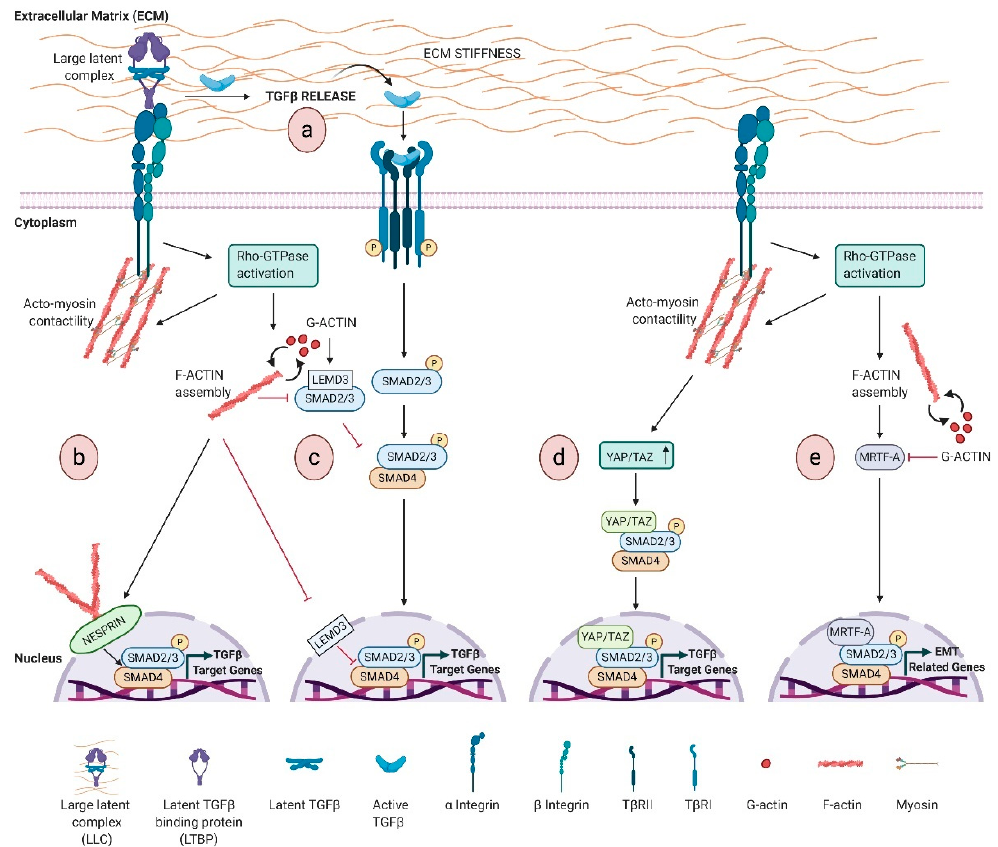
Figure 1. Schematic representation of transforming growth factor β (TGF β ) signaling regulation by actin remodeling induced by extracellular matrix (ECM) stiffness. Activation of Rho GTPase by mechanical cues promotes F-actin assembly and actin cytoskeleton contractility, which activates TGF β signaling by: ( a ) Inducing TGF β ligand release and activation. The ECM-integrin-actin cytoskeleton linkages allow integrin to shift toward an active configuration that favors TGF β release from LTBP/latent TGF β complex. Active TGF β initiates signaling via TGF β receptors, which ultimately drives the phosphorylation-dependent formation of SMAD2/3-4 complex. This complex translocates to the nucleus and facilitates the transcription of TGF β -dependent genes; ( b ) Accumulating at the front of the nucleus of the lamin-binding protein Nesprin-2, which induces SMAD nuclear localization; ( c ) Inhibiting the formation of both cytosolic and nuclear LEMD3-SMAD2/3 complexes, resulting in the relief of LEMD3 negative regulation; ( d ) Activating YAP/TAZ pathway, which regulates both SMAD2/3 shuttling and SMAD-dependent transcriptional activity; ( e ) Controlling myocardin-related transcription factor A (MRTF-A) localization to mediate the SMAD-dependent transcriptional activity.